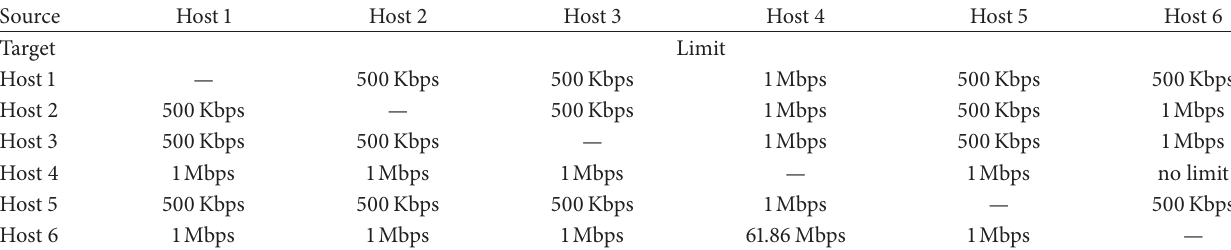
Table 3: Traffic shaping policies.